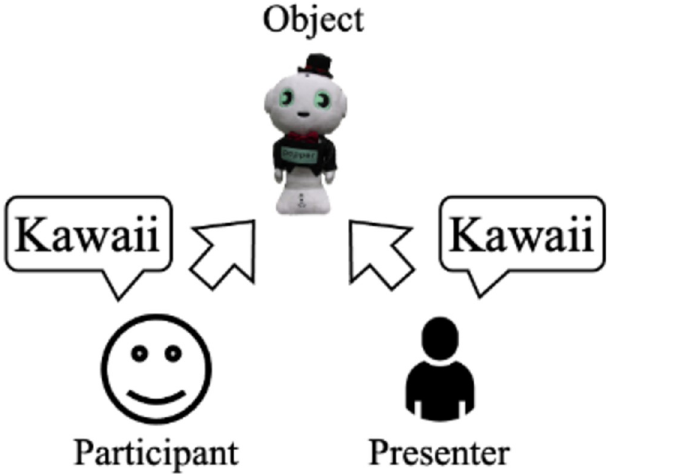
Fig 13. Summary of Experiment II’s